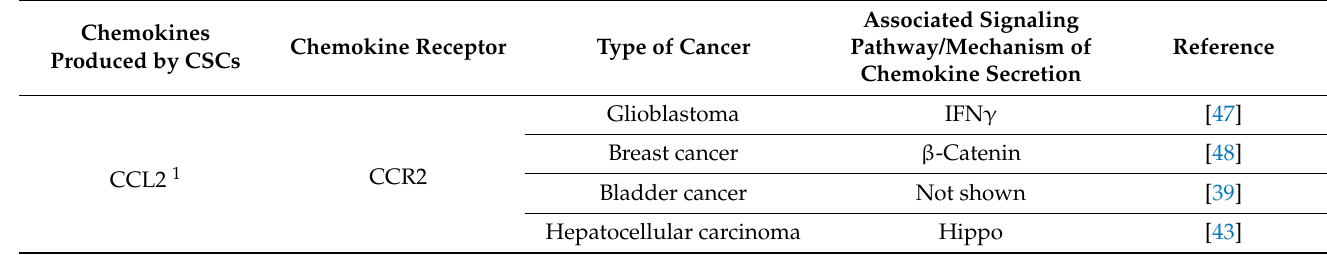
Table 1. CSCs secrete cytokines and other soluble protein molecules to recruit macrophages. Chemokines Produced by